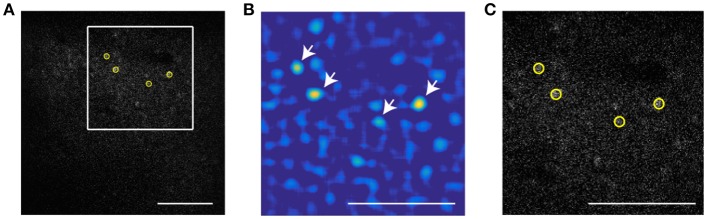
Particle finding via bandpass filtering in the static channel. The scale bar is 100 μm. (A) Typical frame acquired by TPSM. The low signal to noise ratio is in most cases unavoidable due to high speed scanning. (B) Bandpassed image of the same frame with lower and higher bandpass of, respectively 4 and 13 pixels. (C) The four brightest cells extracted by the algorithm (yellow circles) Scale bar is 100 microns. White arrows show the brightest cells in the bandpassed image.